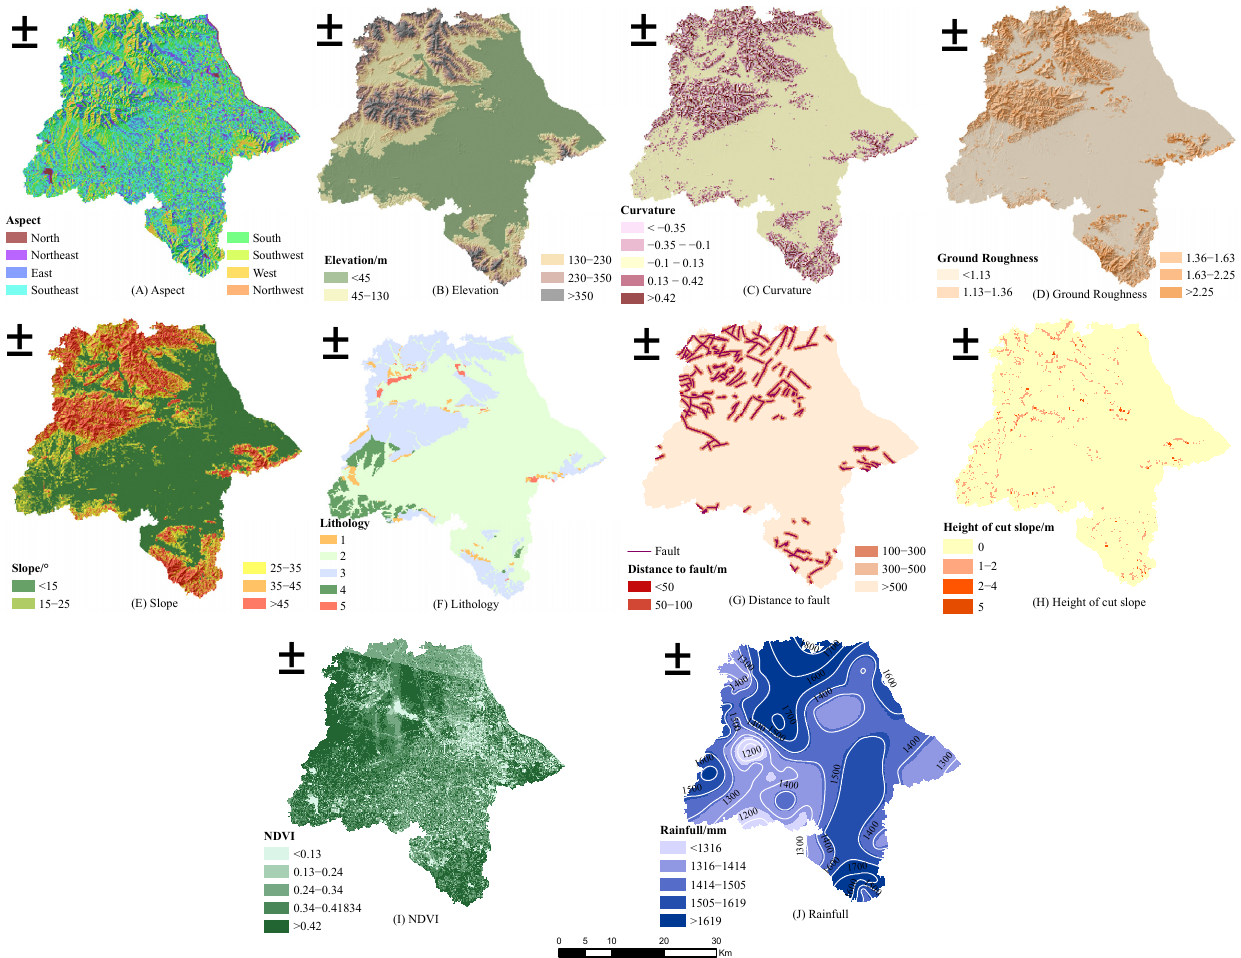
Figure 3. Classification diagram of each evaluation factor.